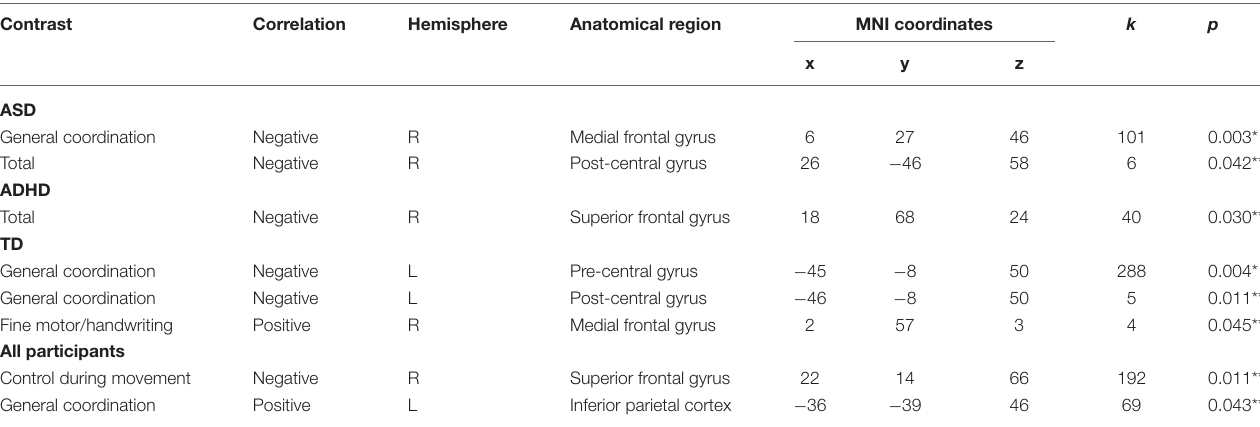
TABLE 3 | Correlation between DCDQ-FC scores and regional grey matter